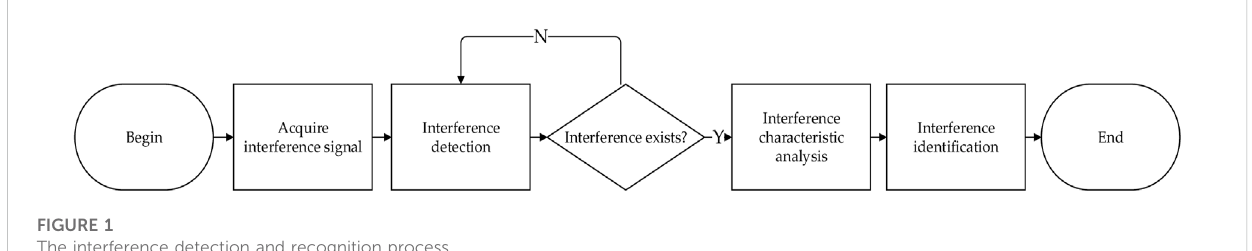
FIGURE 1 The interference detection and recognition